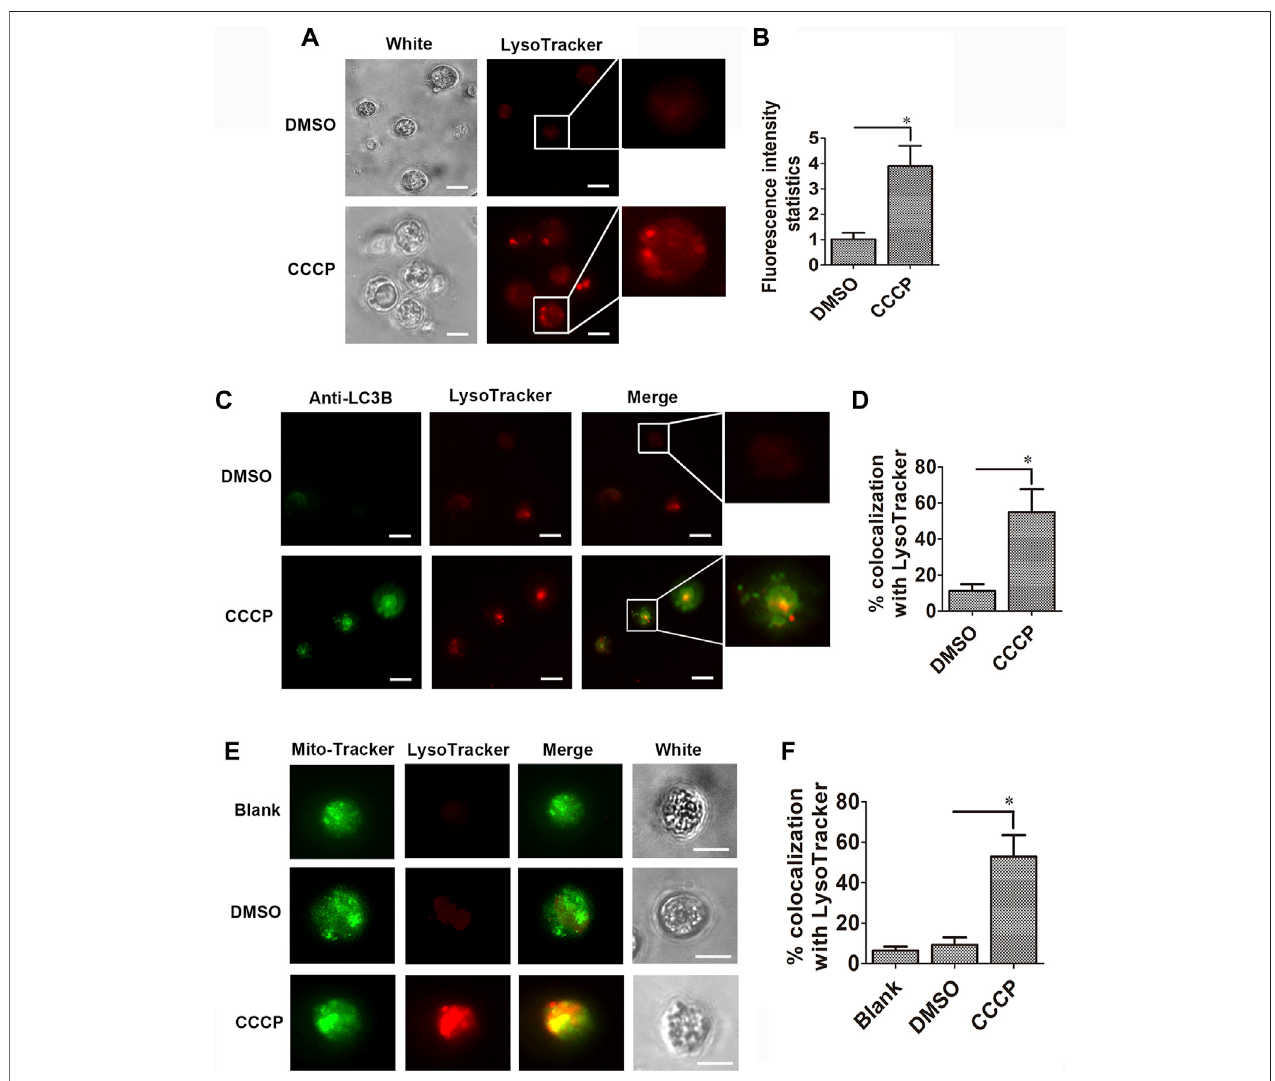
FIGURE 6 | Co-localization of Cg LC3 and mitochondria with lysosomes. (A) Red signals of lysosomes in CCCP-treated hemocytes. (B) Statistical analysis of lysosomes in CCCP-treated hemocytes. (C) Co-localization of LC3B with lysosomes in CCCP-treated hemocytes. (D) Quantity of LC3B co-localized with lysosomes in CCCP-treated hemocytes. (E) Co-localization ofmitochondriawithlysosomesin CCCP-treated hemocytes. (F) Quantity ofmitochondria co-localizedwithlysosomesin CCCP-treated hemocytes. The fl uorescence signals were captured under the same exposure parameters. The vertical bars are shown as mean ± S.D. (N = 3). *: p < 0.05 ( t